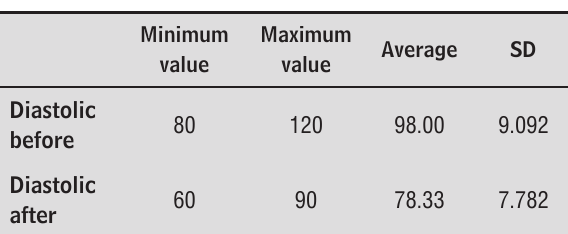
Table 2 - Diastolic blood pressure scores of ESF users before and after an intervention program in the SUS, Iguaí, 2010 (n = 30)